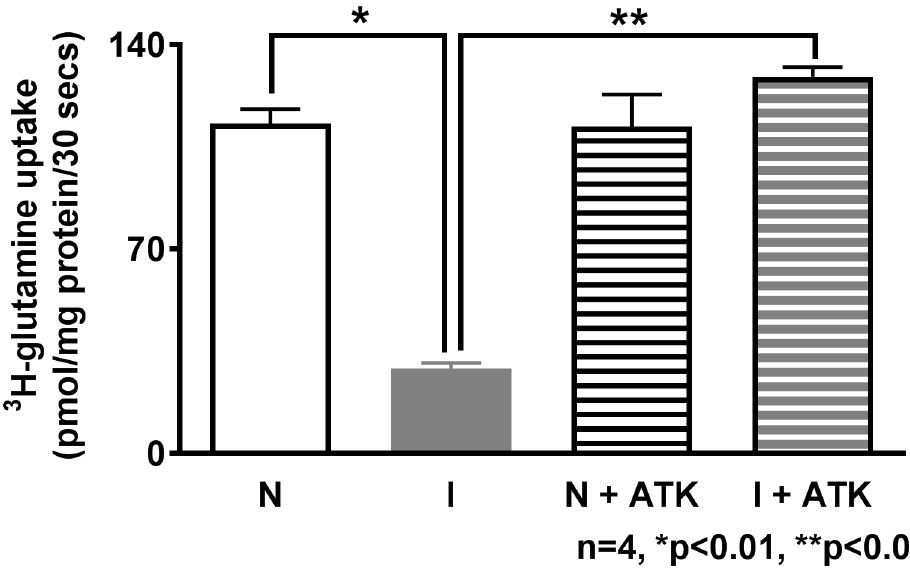
Fig 2. Effect of ATK on Na-glutamine co-transport in villus cell BBMV. Na-dependent glutamine uptake was significantly decreased in villus cell BBMV from the chronically inflamed intestine and this inhibition was reversed with in vivo ATK treatment. Na-glutamine co-transport was not affected in the normal intestine.